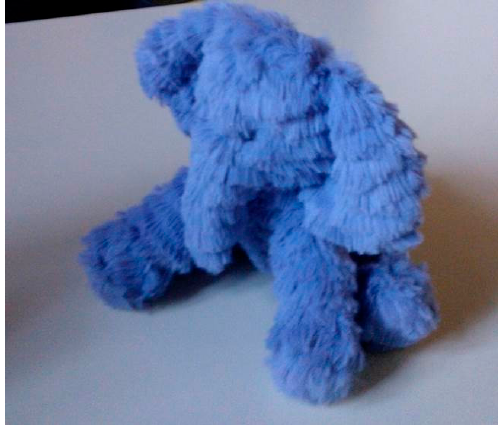
Figure 1. The stuffed toy